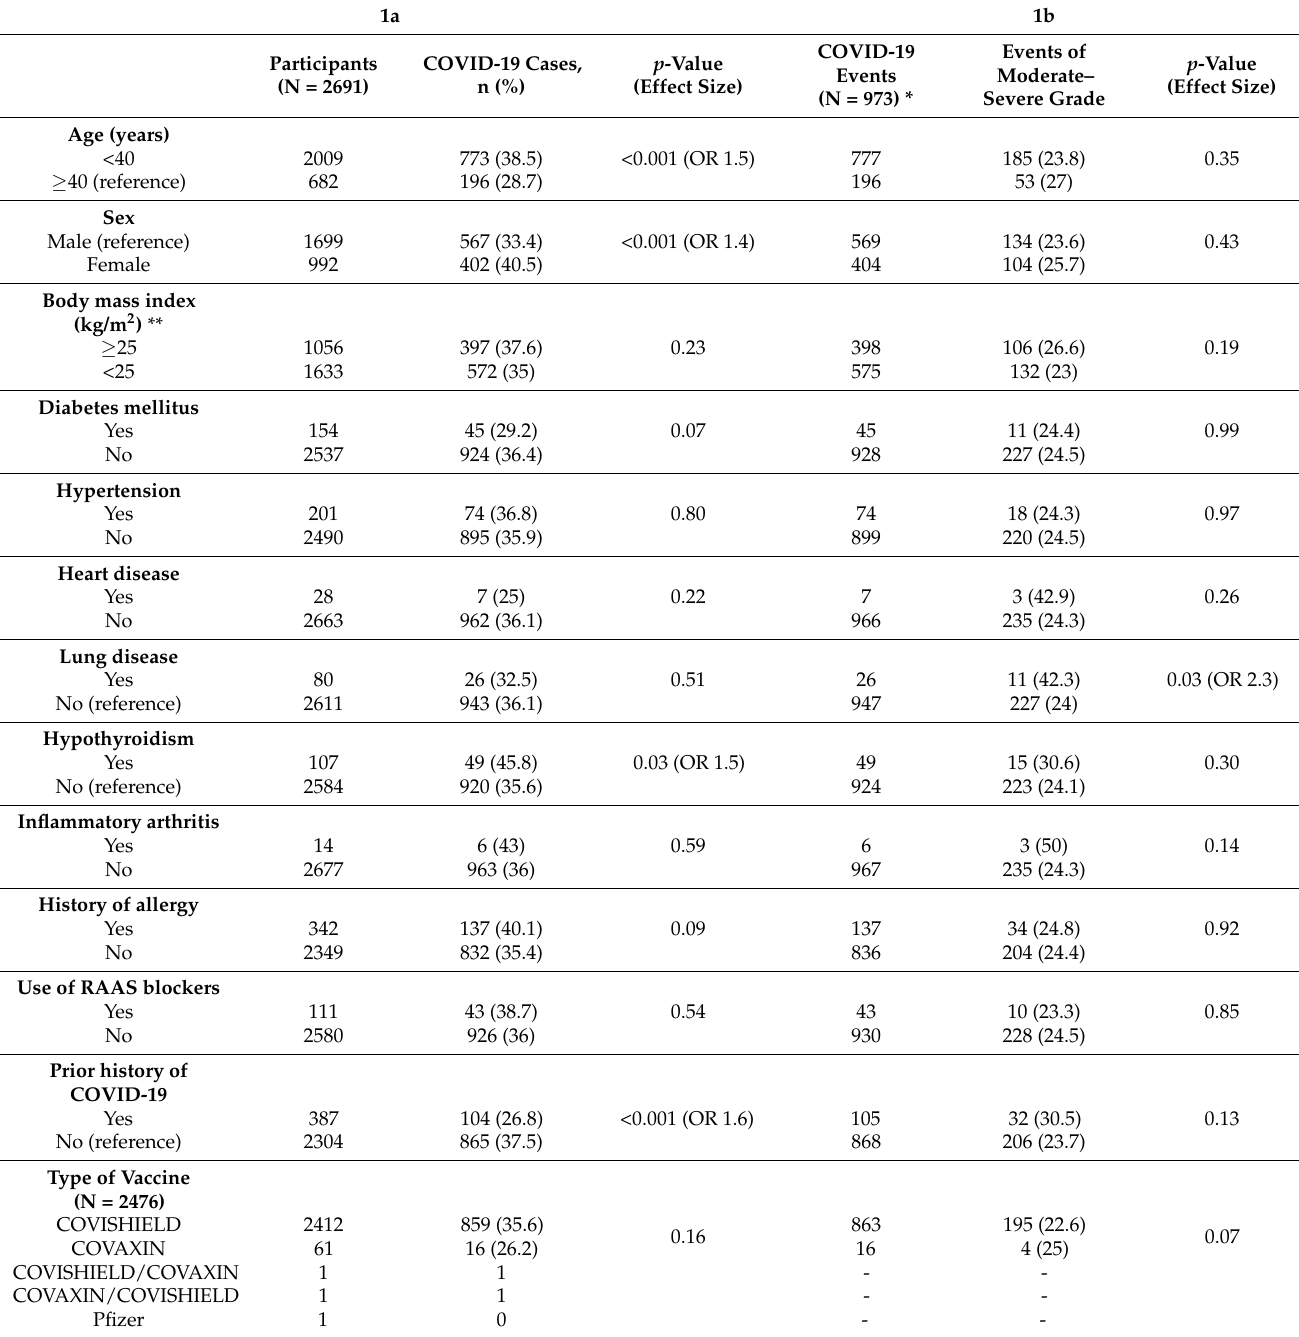
Table 1. Baseline characteristics of study population and bivariate analysis to determine risk factors of COVID-19 occurrence and severity in health care workers during the second wave of pandemic (between 16 March and 31 May